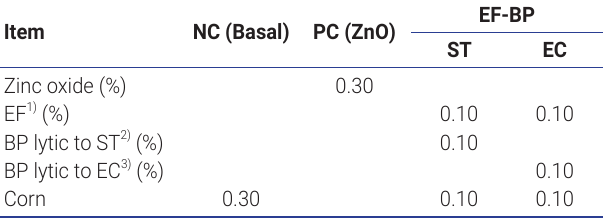
Table 2. Supplementation of the experimental